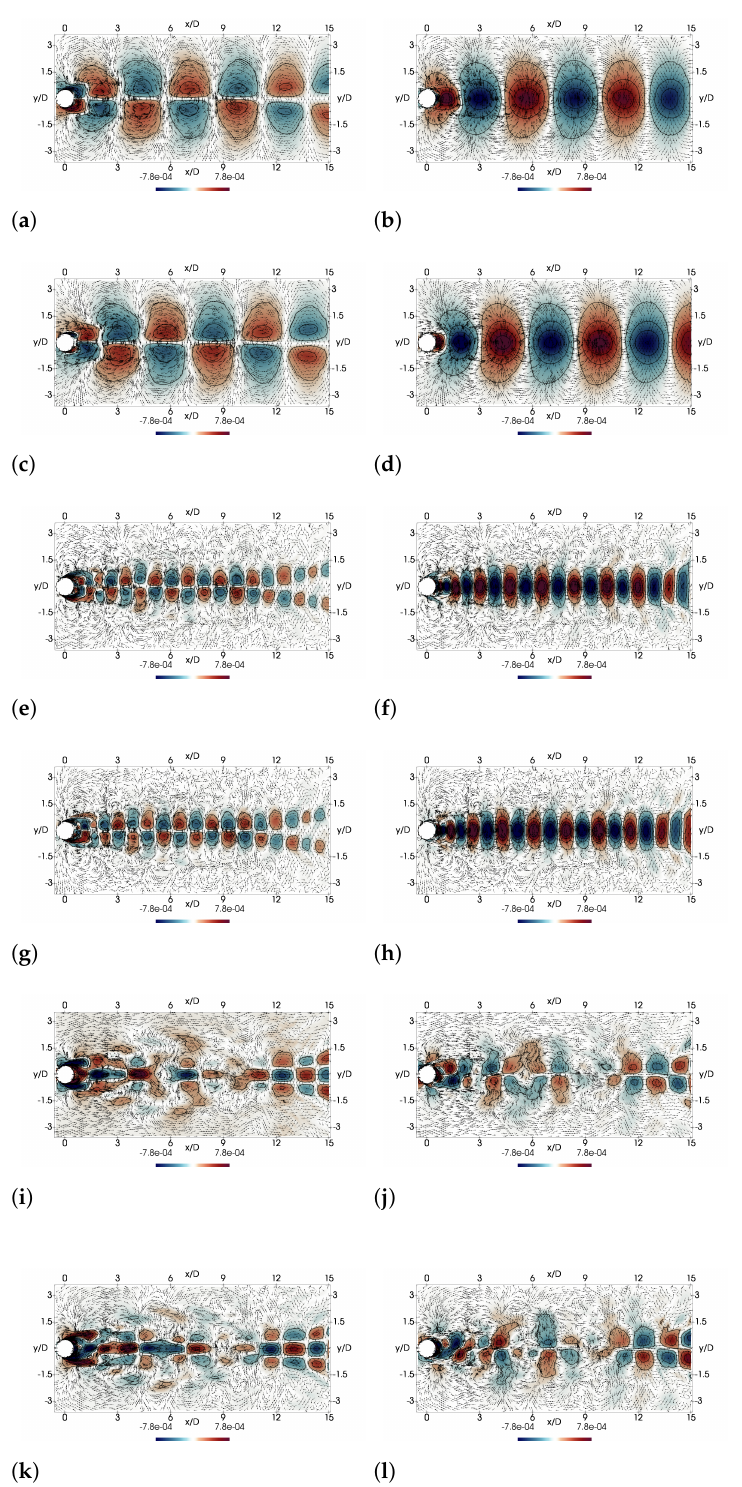
Figure 7. First six modes of the stream-wise ( a , c , e , g , i , k ) and cross-stream velocity fluctuations ( b , d , f , h , j , l ) in the initial